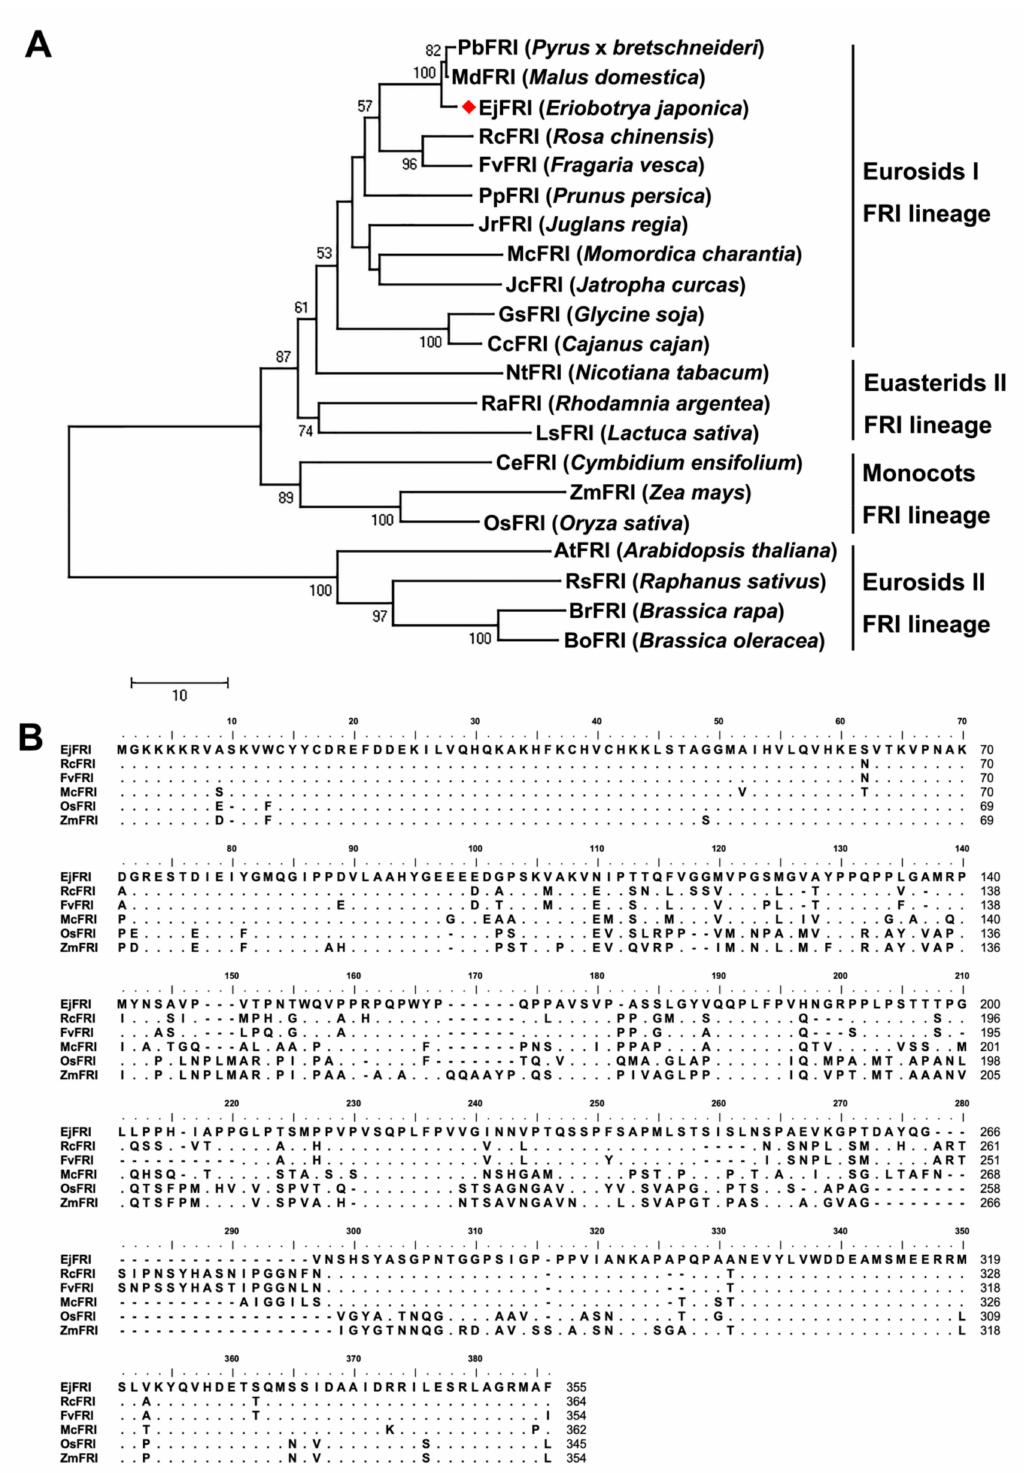
Figure 1. Sequence analysis of EjFRI. ( A ) Phylogenetic analysis of EjFRI protein orthologs. Sources of the orthologous proteins are indicated in Supplementary Table S2. The percentage of replicate trees in which the associated taxa clustered together in the bootstrap test (1000 replicates) is shown next to the branches. Bootstrap values > 50 are shown on the tree. ( B ) Comparison of amino acid sequences of EjFRI with other reported FRIGIDA-like proteins in NCBI database. Amino acid residues identical to EjFRI are indicated as dots. To optimize the alignment, dashes were introduced into the